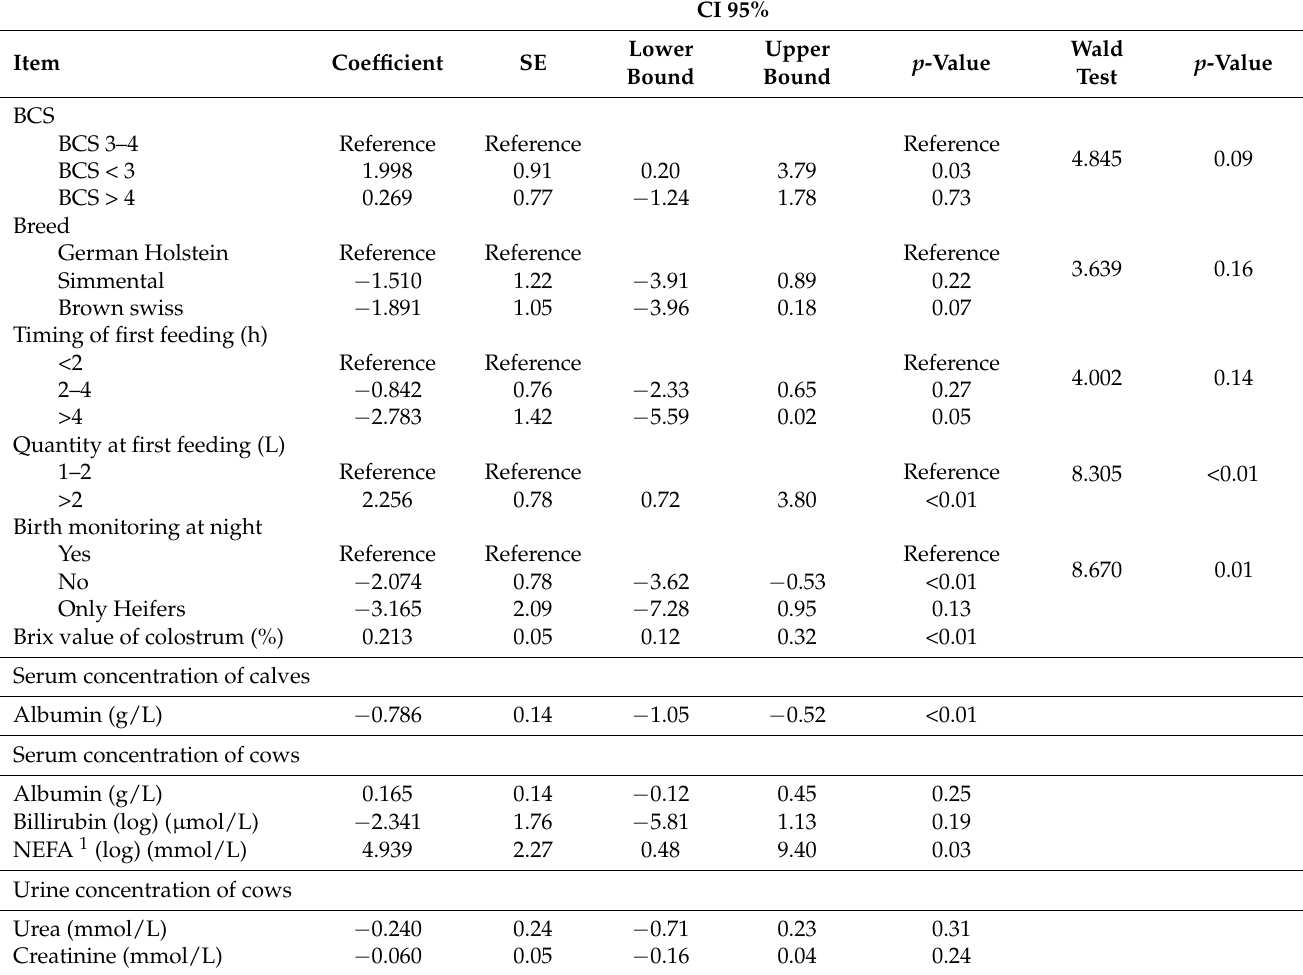
Table 3. Coefficients, SE and 95% CI of variables included in the final linear regression model regarding the association between serum immunoglobulin concentration of 511 calves between March 2017 and March 2018 as measured by an indirect proxy measurement and cow-level variables measured 1 to 3 weeks before calving, including Brix values of colostrum samples. CI